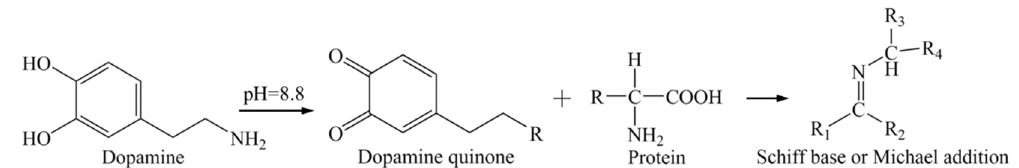
Figure 3. Mechanism of dopamine immobilized antibody.